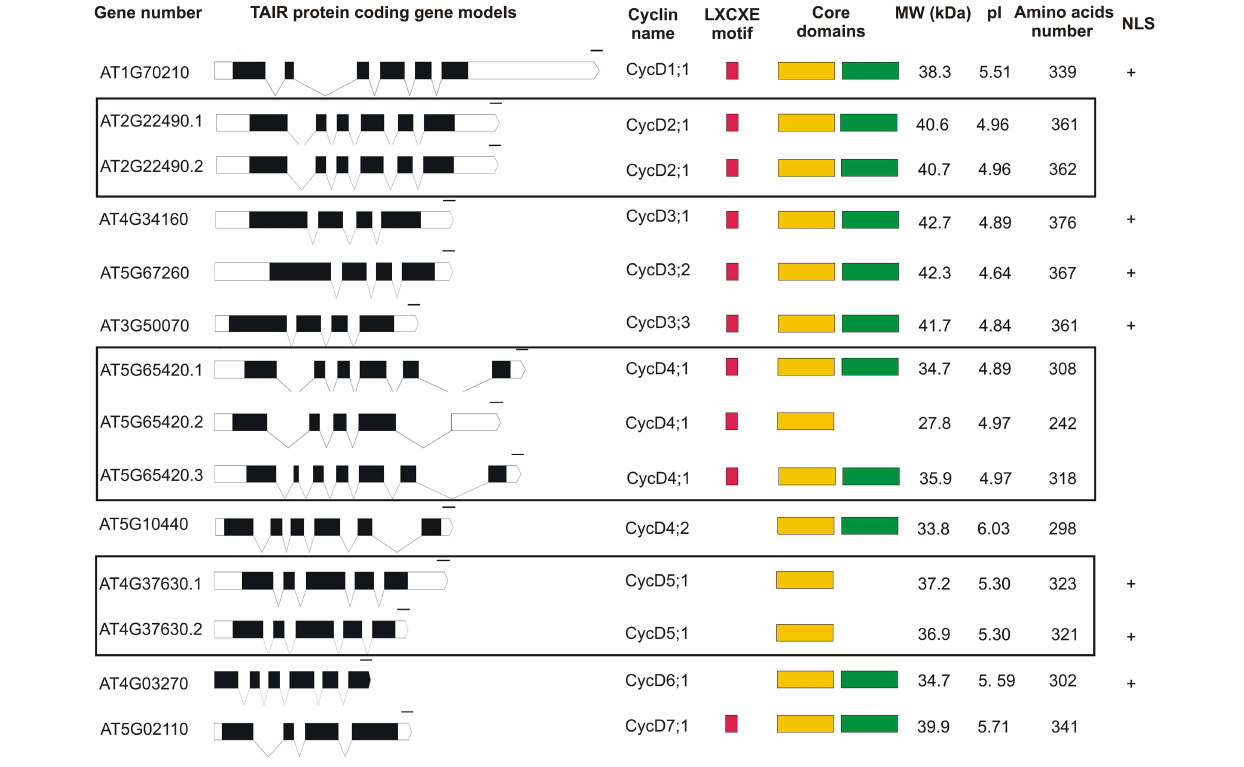
FIGURE 1 | The genomic and protein organization of Arabidopsis D-type cyclins. The white and black bars represent the untranslated (UTRs) and coding region respectively. The regions within slanting lines represent